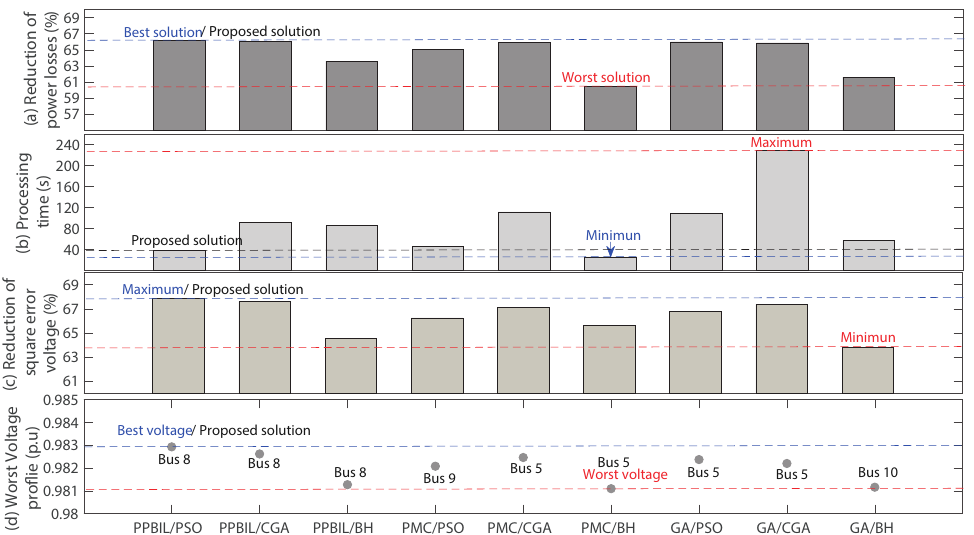
Figure 7. Results obtained with the 10 bus test system. ( a ) Reduction of power losses (%); ( b ) Processing Time (s); ( c ) Reduction of square error voltage (%); ( d ) Worst Voltage profile (p.u).